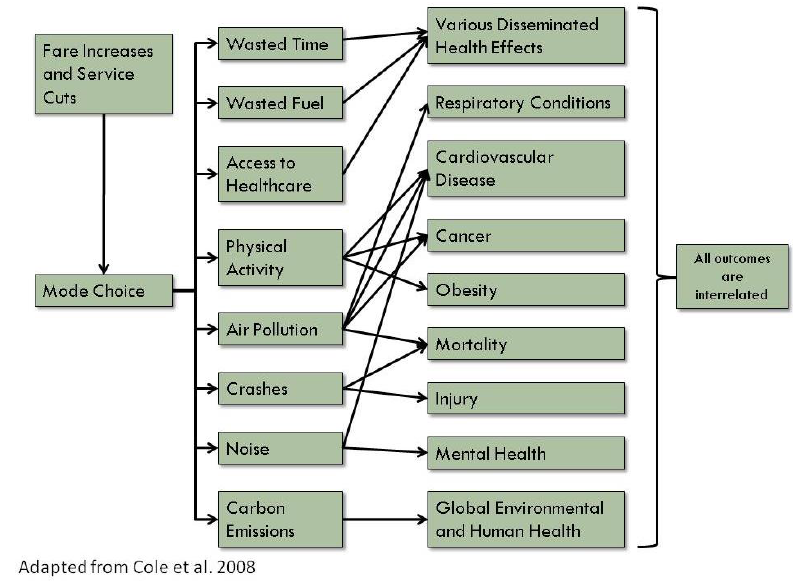
Figure 2. Pathways for the Health Impacts of Public